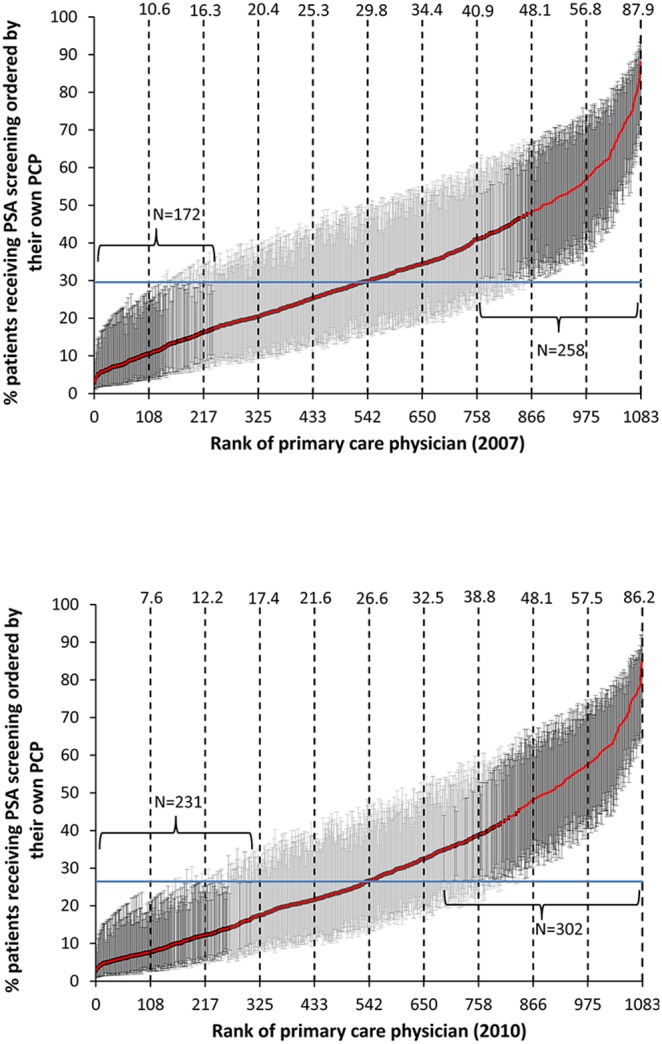
Cumulative distribution of 1,083 Texas primary care physicians (PCPs) by the adjusted percentage of their male patients age 75 and older who underwent prostate specific antigen (PSA) testing ordered by the PCP in 2007 (top panel) and 2010 (bottom panel).Only PCPs with at least 20 male patients 75+ in their panels in both years are included. The vertical lines denote the 95% confidence intervals of the estimates, derived from the multilevel models presented in Table 1. Dark lines indicate PCPs whose PSA testing rate was significantly different from the mean rate for all PCPs.